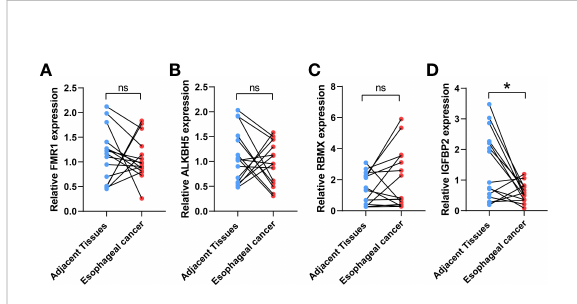
FIGURE 4 Validation of the expression levels of target IGFBP2 . The IGFBP2 expression in ESCA (n = 15), and adjacent normal tissues (n = 15) was evaluated by qRT-PCR including FMR1 (A) , AKBH5 (B) , RBMX (C) , IGFBP2 (D) ; the results were analyzed using paired sample t test. Results are expressed as mean ± standard deviation (SD).